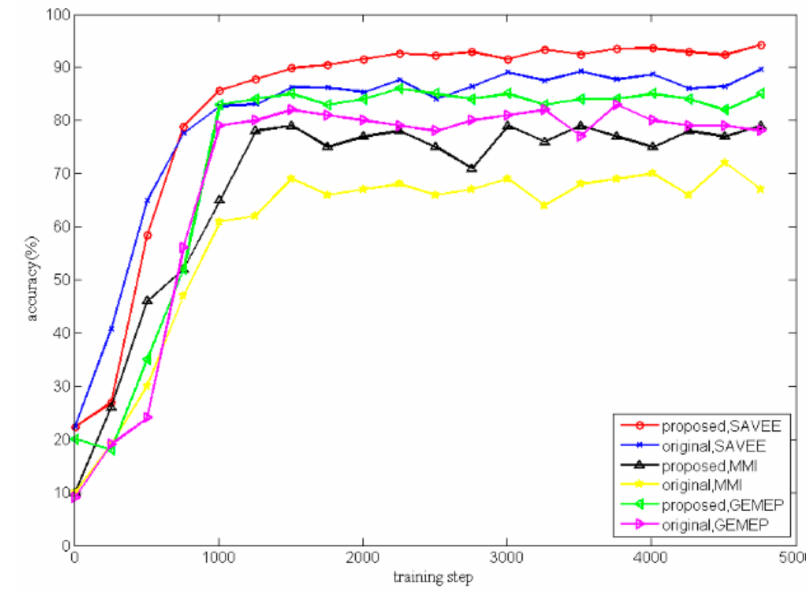
Figure 6. Training convergence curves on different